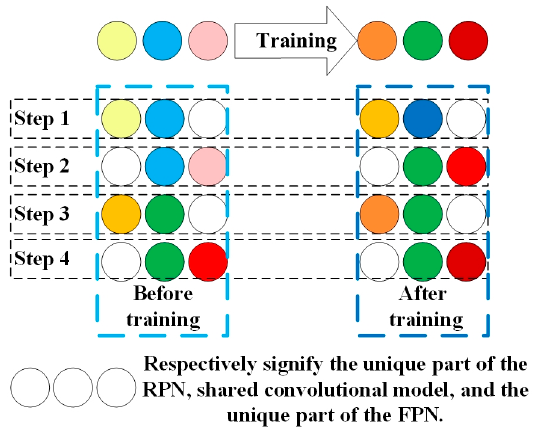
Figure 5. The method of alternating training regional proposal network (RPN) stage and fast R-CNN (FRN) stage.